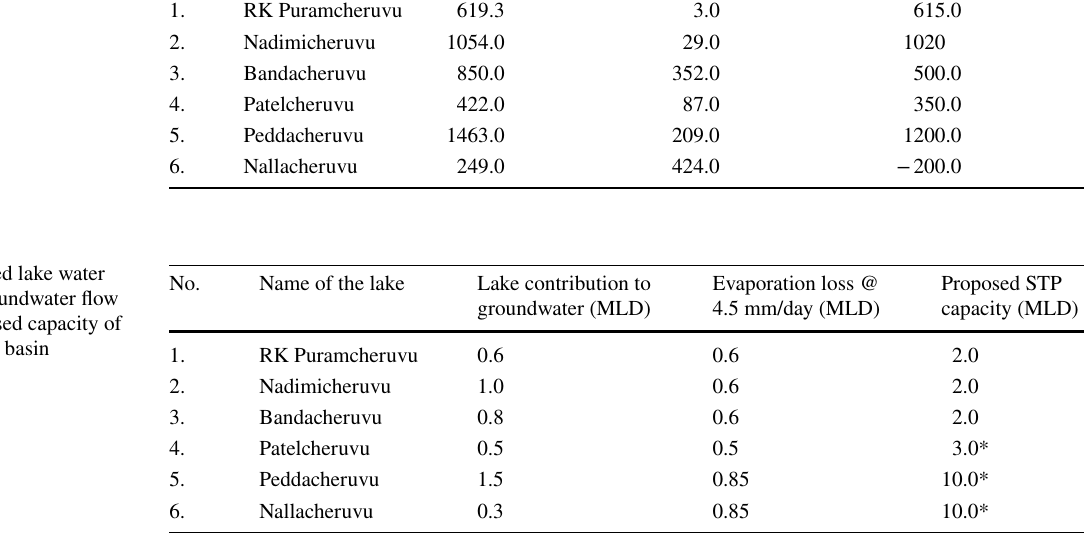
Table 4 Zone budget of lakes in NE Musi basin